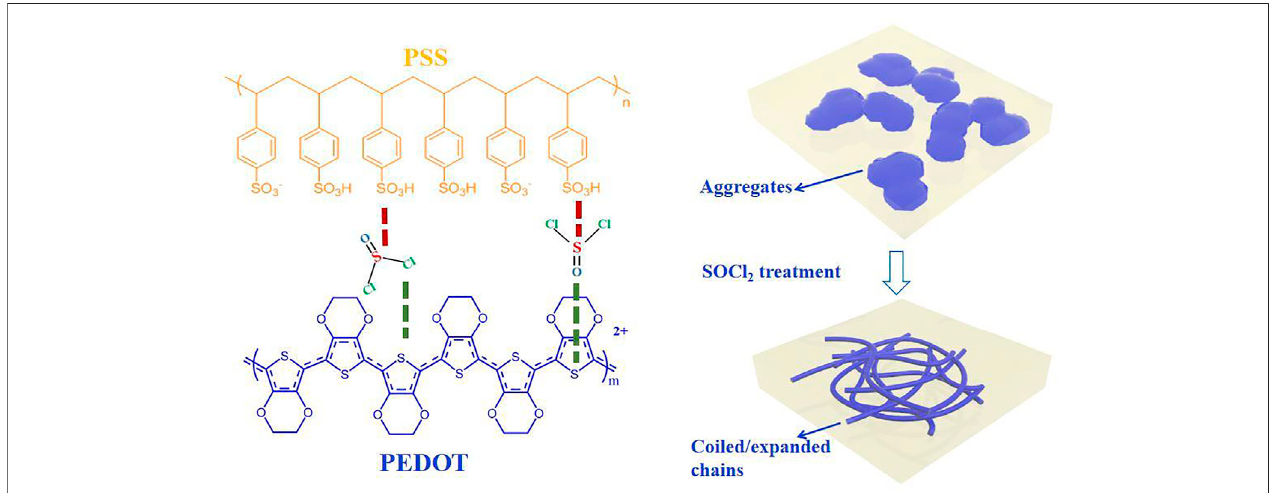
FIGURE 1 | Schematic diagrams of inter-molecular interactions among PEDOT, PSS, and SOCl 2 , and morphology evolution of the PEDOT:PSS fi lms induced by SOCl 2